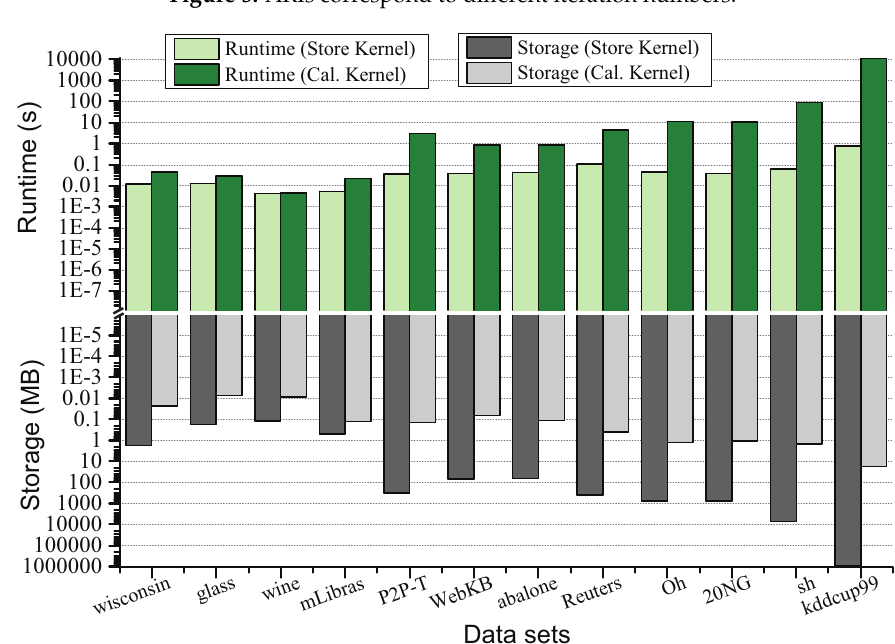
Figure 6. Runtime and storage performance with respect to using kernel utilization or